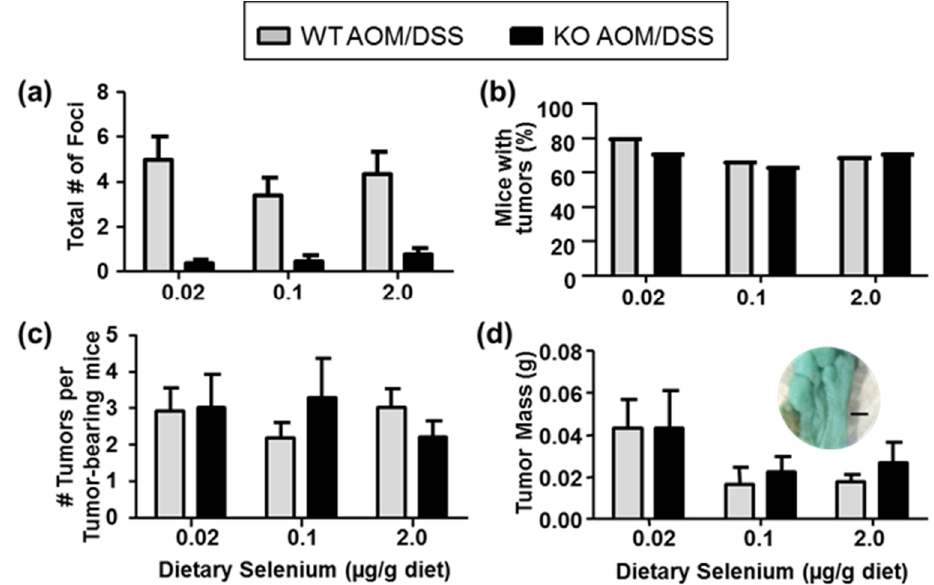
Figure 1. Aberrant crypt foci (ACF) and tumor formation modulated by Selenof genotype and dietary selenium. ( a ) AOM/DSS-treated Selenof-KO mice formed fewer chemically induced ACF than WT littermates (two-way ANOVA, genotype p < 0.0001), independent of dietary selenium levels. ( b ) Development of macroscopic tumors, and ( c ) number of tumors per colon in Selenof-KO and WT mice did not differ. ( d ) Tumor mass appeared slightly modified by dietary selenium (two-way ANOVA, p = 0.117); insert shows stained colon tissue of WT mouse with tumors on selenium- deficient diet (size bar indicates 1 mm).